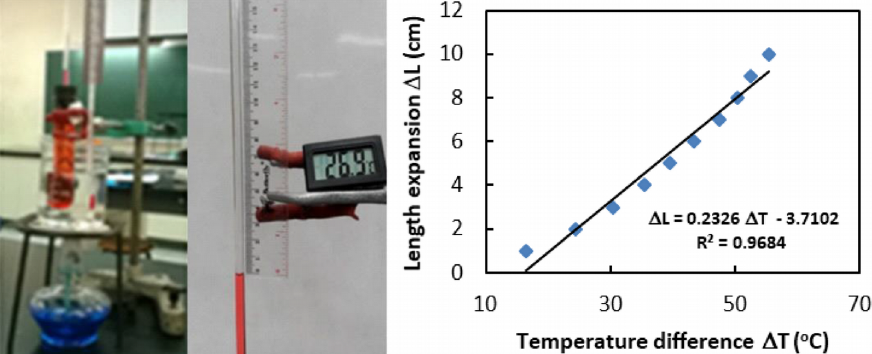
Figure 7. Second experiment design to construct the concept of linear thermal